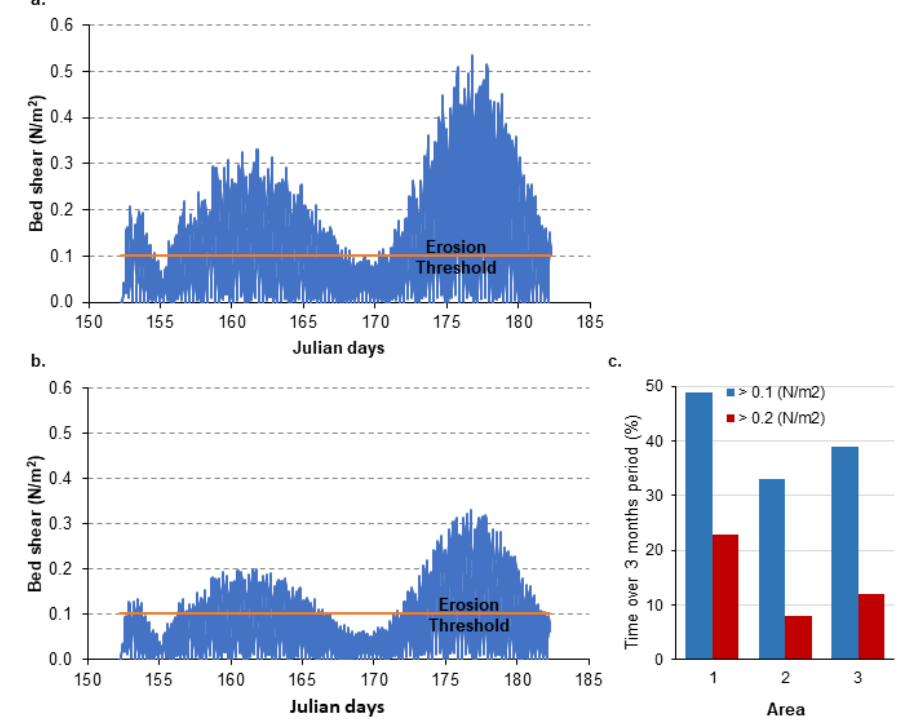
Figure 13. Modelled bed shear stress results for the three months period in ( a ) Area 1 and ( b ) Area 3. ( c ) Comparison of the percent time in the three months modelled period where the bed shear stress exceeded the erosion threshold of 0.1 N/m 2 considered for the type of sediments found in the study area [49] and 0.2 N/m 2 .